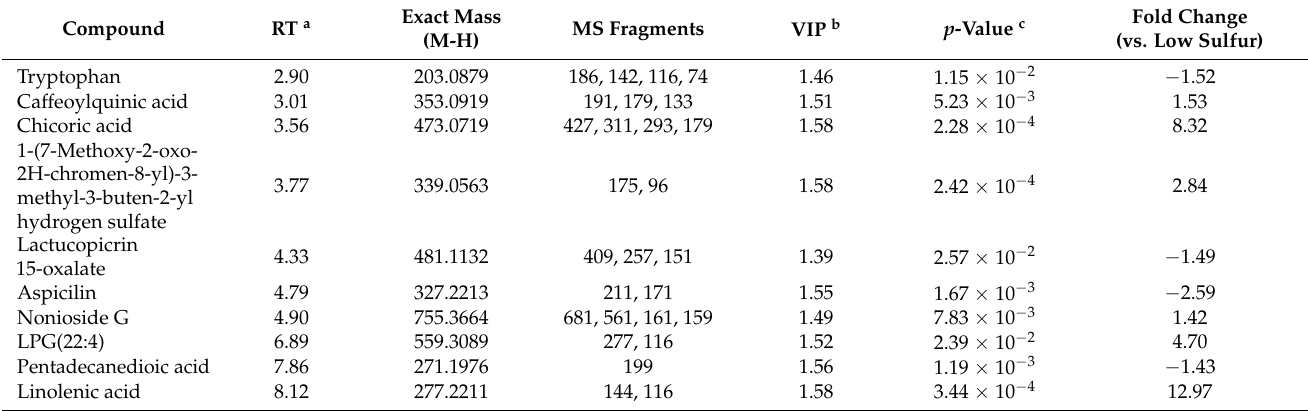
Table 3. Identification of lettuce metabolites contributes to the sample groups’ separation based on the PLS-DA score plot for UPLC-Q-TOF MS analysis and their fold changes.